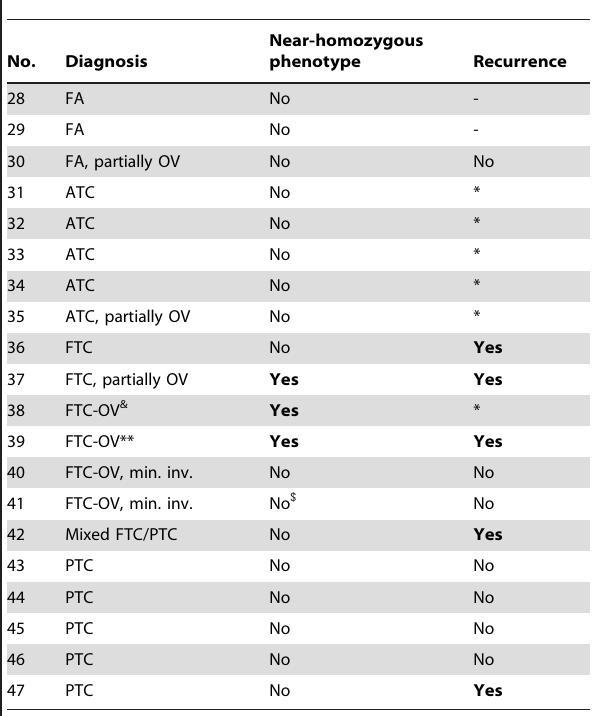
Table 2. Summary of results of the analysis of the 20 tumours in the validation cohort: diagnosis, near-homozygous phenotype and